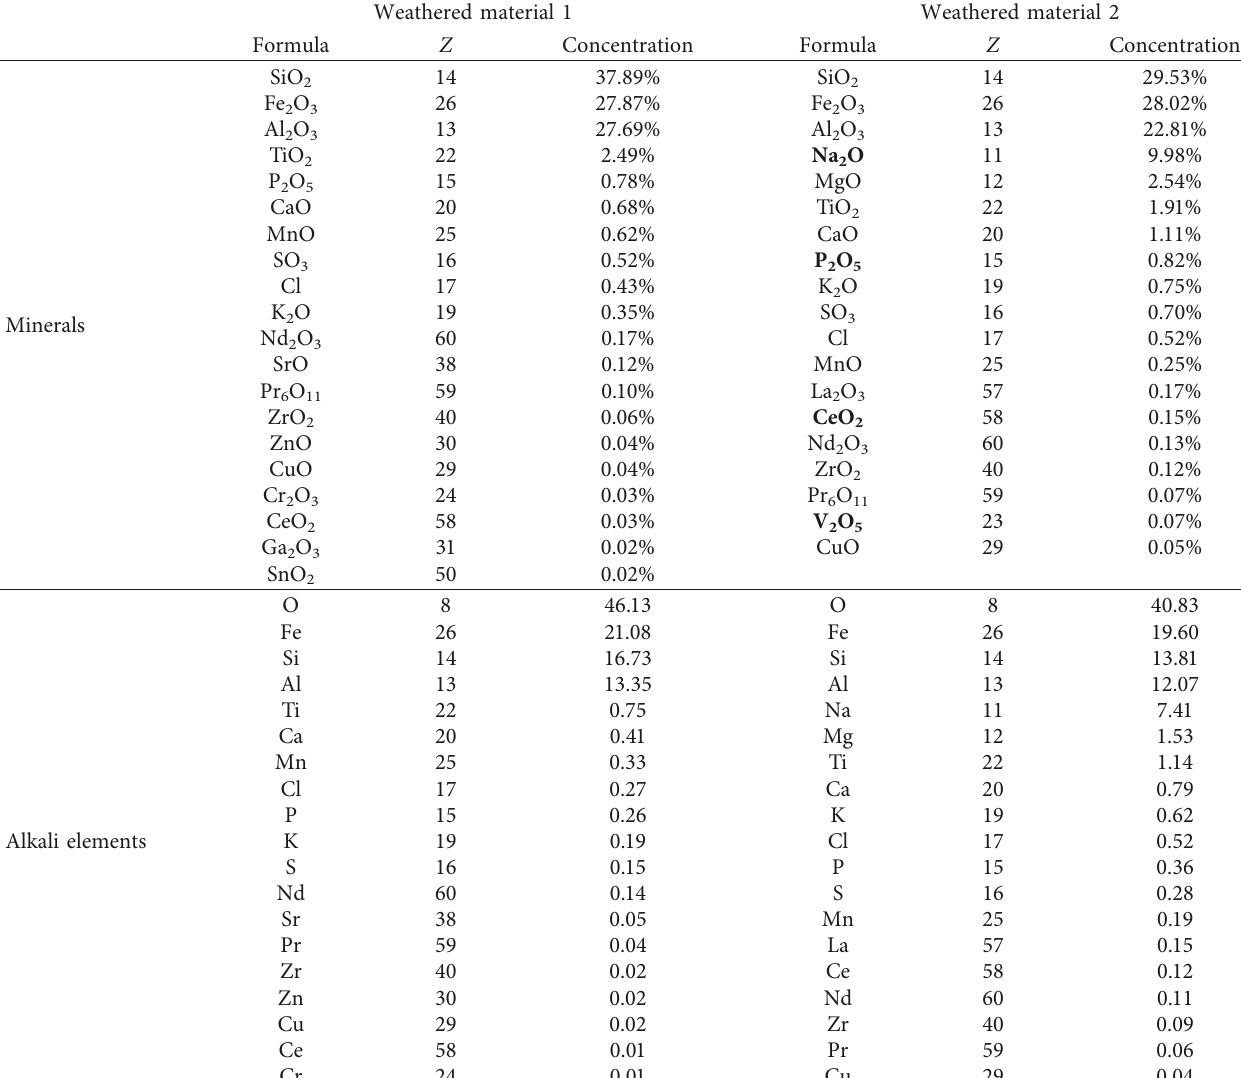
Table 4: Selective sample of XRF analysis in weathered